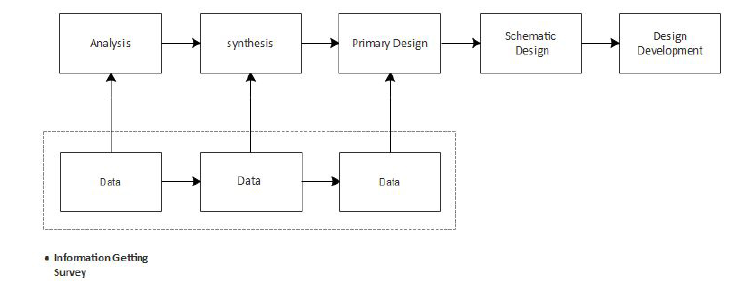
Figure 9. Questionnaire participation model (source: